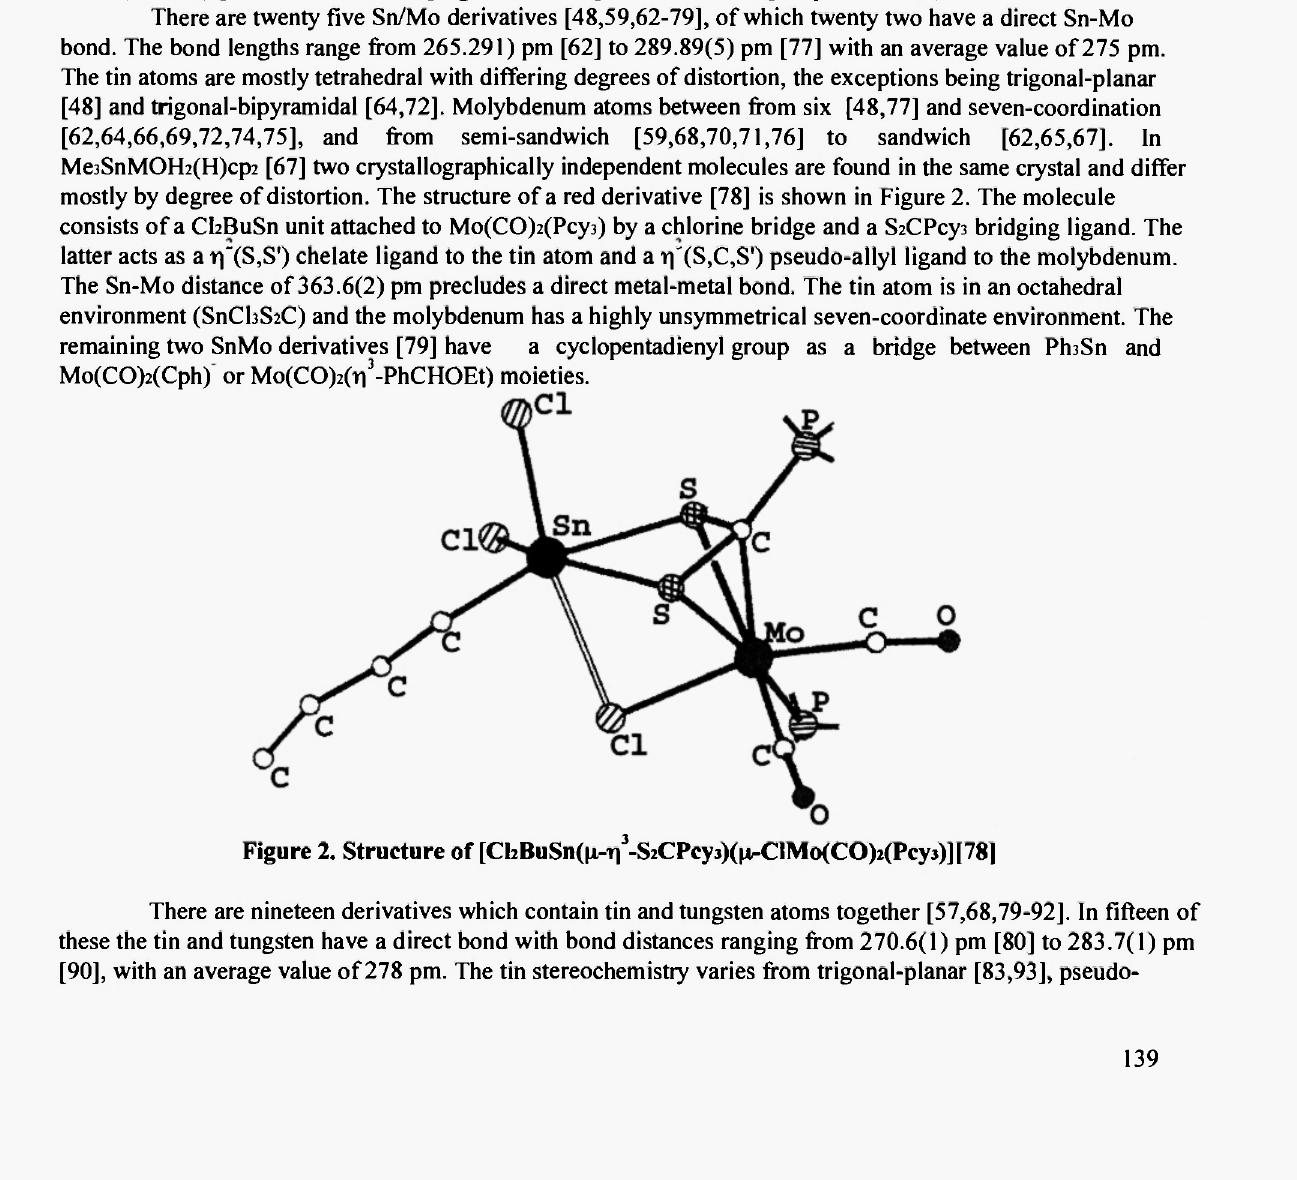
Figure 2. Structure of [ChBuSn^-V-S2CPcy 3